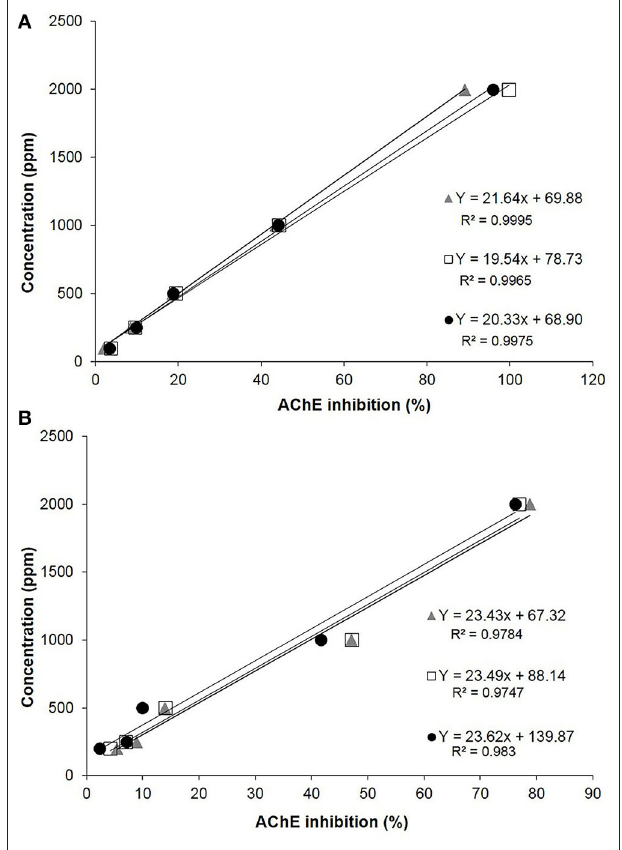
FIGURE 4 | Acetylcholinesterase (AChE) inhibitory curves and respective R 2 values obtained for juglone (A) and 1,4-naphthoquinone (B)